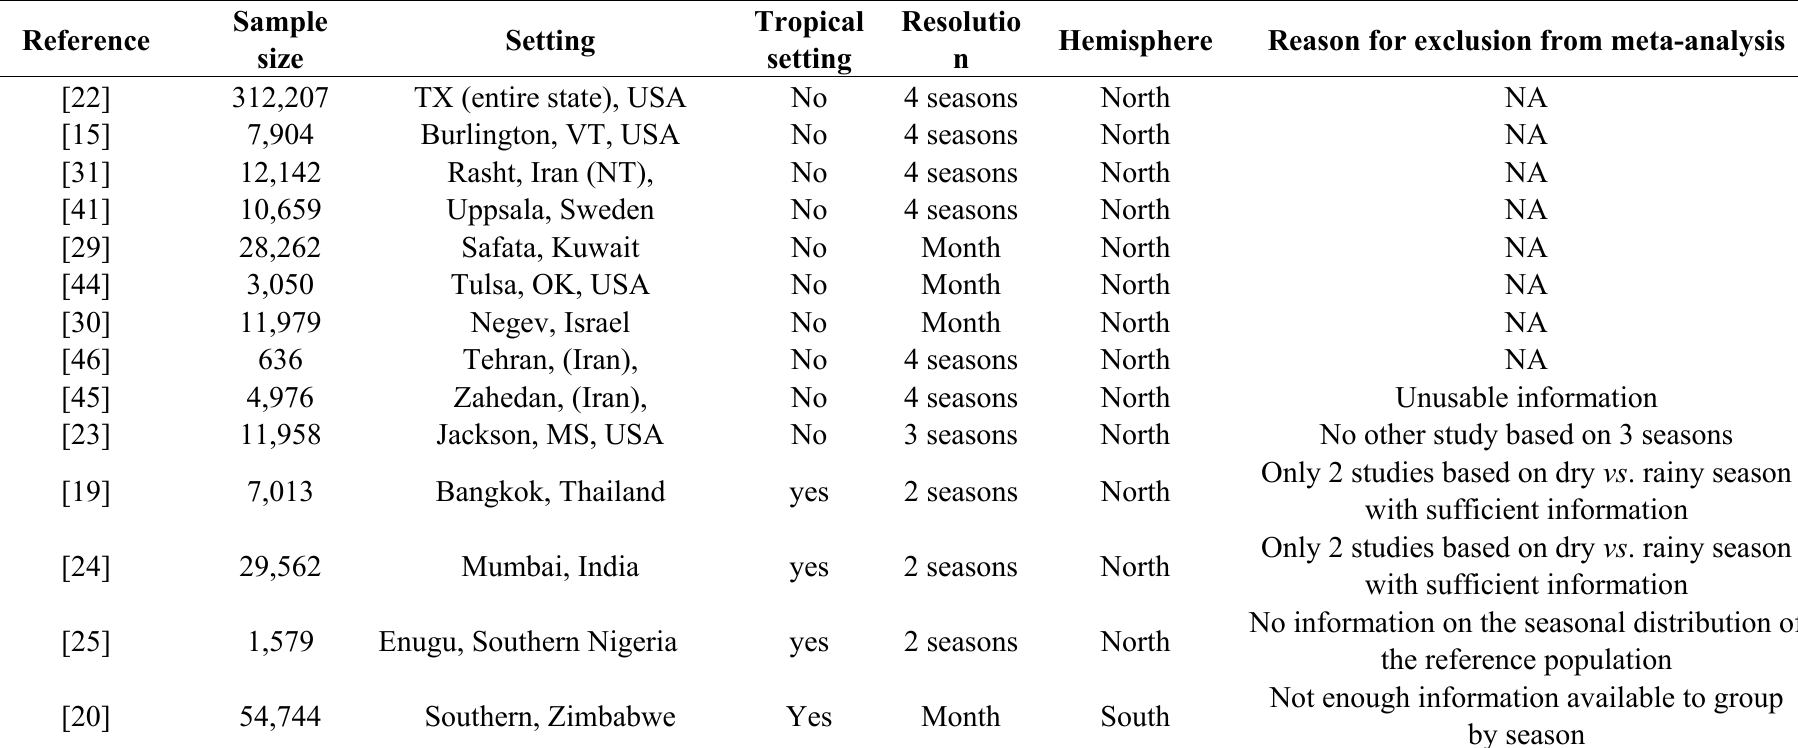
Table A5. Studies examined for the meta analysis of the influence of season of birth on preeclampsia incidence.